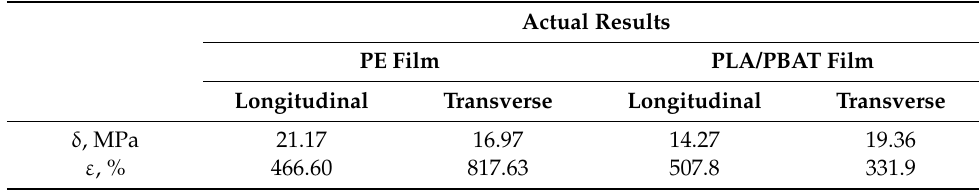
Table 2. Physical and mechanical test